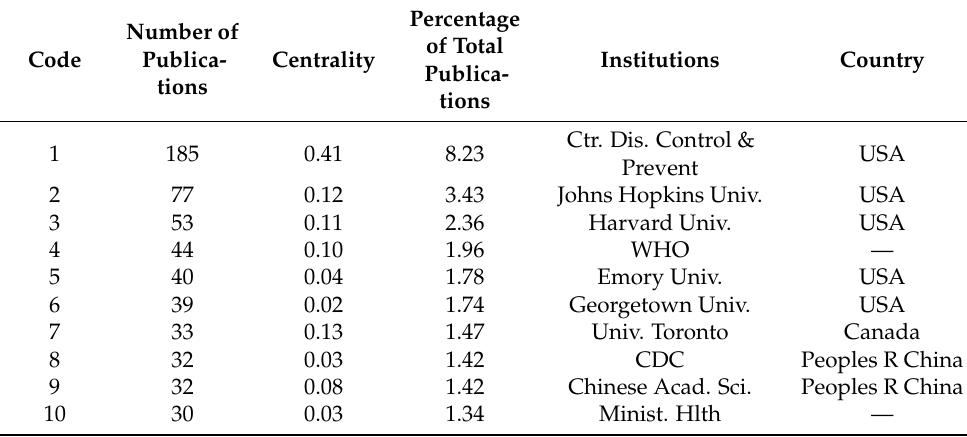
Table 2. The top 10 institutions in terms of publications (30 times or more).